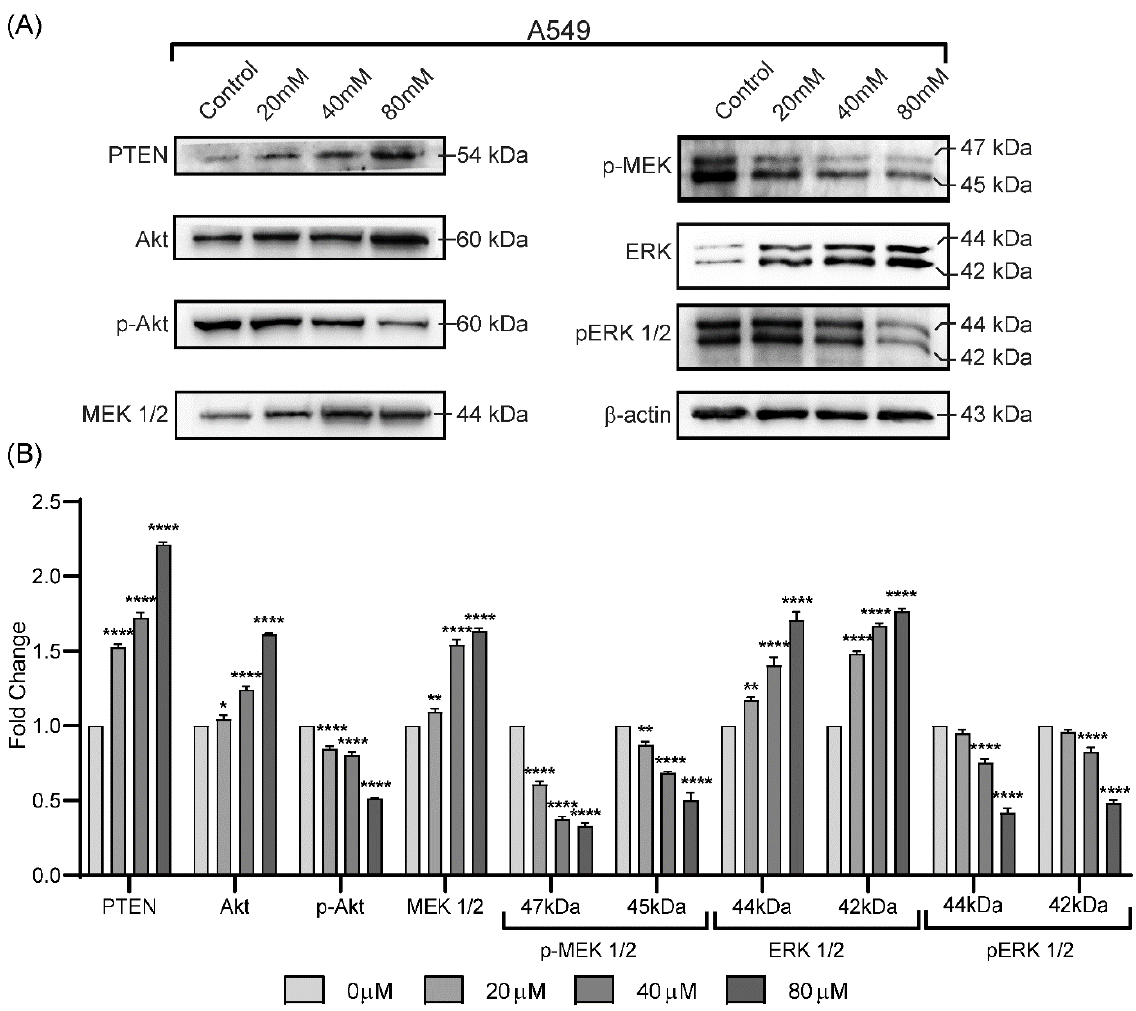
Figure 4. Lactucin inhibits A549 lung cancer cells by downregulating the MAPK/ERK pathway. ( A ) WB analysis of PTEN, Akt, p-Akt, MEK 1/2, p-MEK, ERK, and pERK 1/2 protein expression in A549 cell after exposure to Lactucin at 0, 20, 40, and 80 μM for 24 h. ( B ) Data are expressed as the means ± standard deviation of triplicate experiments. * p < 0.05, ** p < 0.01, and **** p < 0.0001 indicate result’s significant difference from the control.